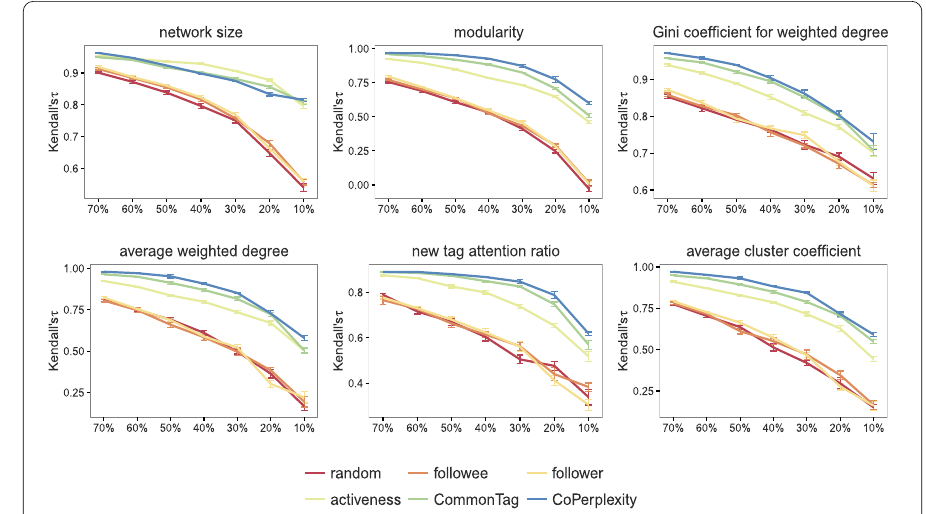
Figure 7 Effectiveness of capturing the attention graph characteristics change. The performance is calculated based on the Kendall’s τ in terms of six graph metrics. The plots show Kendall’s τ coefficients for different sampling strategies along with the drop of sample size using Paris users data set. The error bar is obtained over 20 independent samples. CoPerplexity outperforms other sampling criteria (weighted schemes) over different sampling conditions, in terms of most graph